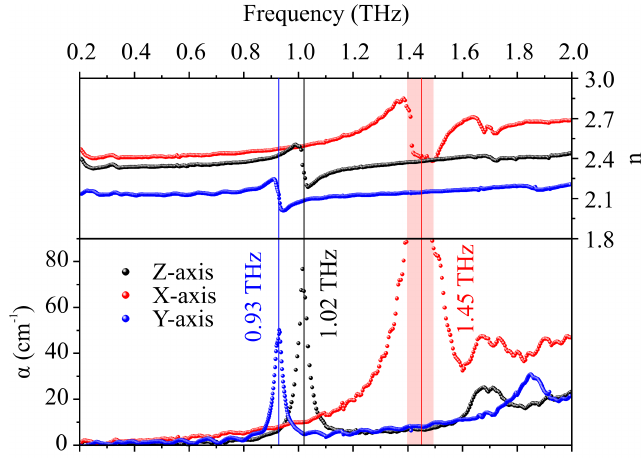
Figure 25. Spectra of the refraction and absorption coeffcients of the GUHP crystal along the three principal dielectric axes at room temperature. The absorption coefficient corresponds to the absorption of the field